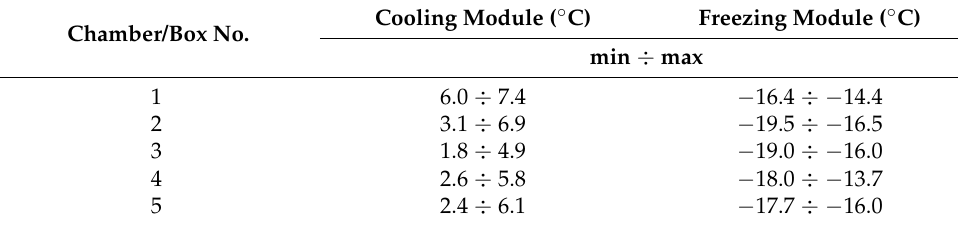
Figure 5. Temperature distribution in the freezing module chambers. Table 1. Temperature of individual chambers of the cooling and freezing module. Chamber/Box No.